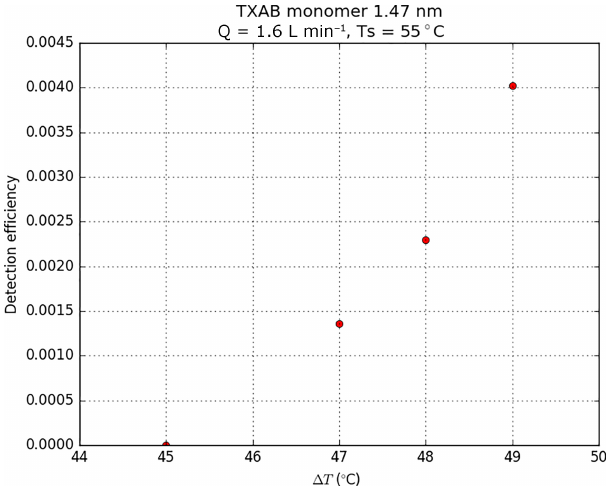
Figure 5. B3010 detection efficiency as a function of flow rate in the sub-2nm range.